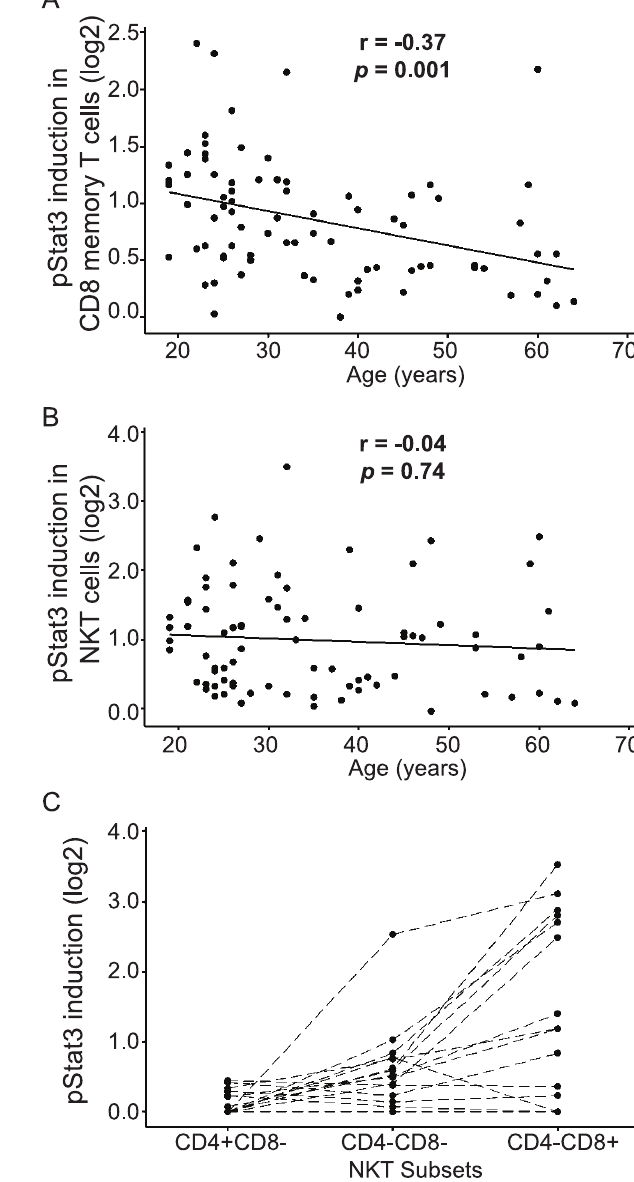
Figure 3. Age-related correlation and subset analysis for IL-23- mediated pSTAT3 induction in CD8 + CD45RO + memory T cells and CD3 + CD56 + NKT cells. Peripheral whole blood was stimulated with 100 ng/ml IL-23 for 15 minutes and pSTAT3 induction was assessed by phospho-flow assay. IL-23 responsiveness was calculated as the log2 ratio of GMFI of pSTAT3 in stimulated vs. unstimulated samples. Age is significantly associated with IL-23 responsiveness in (A) CD8 + CD45RO + memory T cells (n=82, r= 2 0.37, p=0.001), but not in (B) CD3 + CD56 + NKT cells (n=82, p=0.50). (C) IL-23 responsive NKT cells are confined to the CD4 2 CD8 + and CD4 2 CD8 2 subsets